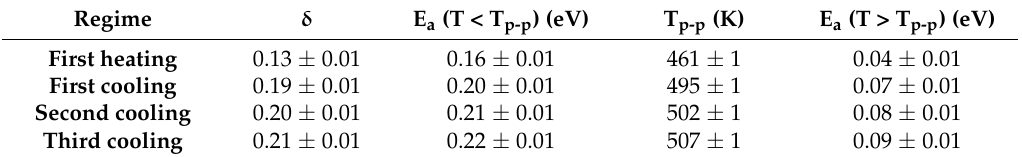
Figure 5. Reciprocal temperature dependence of the Gd 0.2 Sr 0.8 FeO 3 − δ logarithmic resistivity. Black straight lines show the thermal activation law processing: (1) first heating, (2) first cooling, and (3) third cooling. Table 2. Oxygen nonstoichiometry indices, activation energies, and electronic transition temperatures for the Gd 0.2 Sr 0.8 FeO 3 − δ ferrite